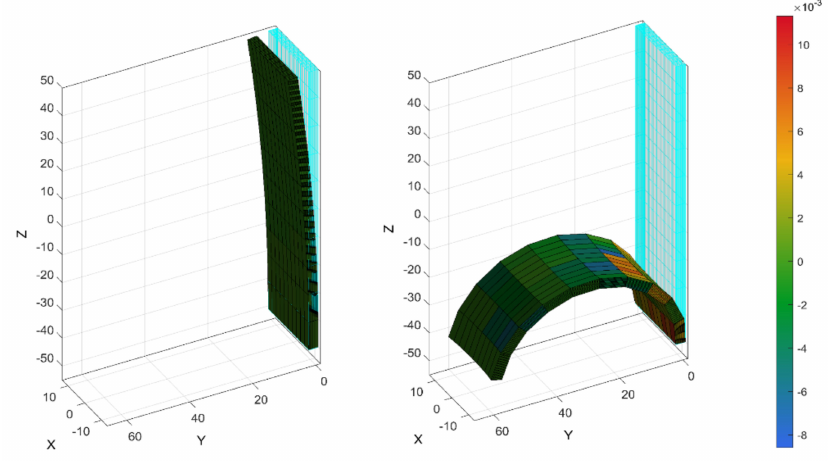
Figure 9. Simulation of bending actuation.